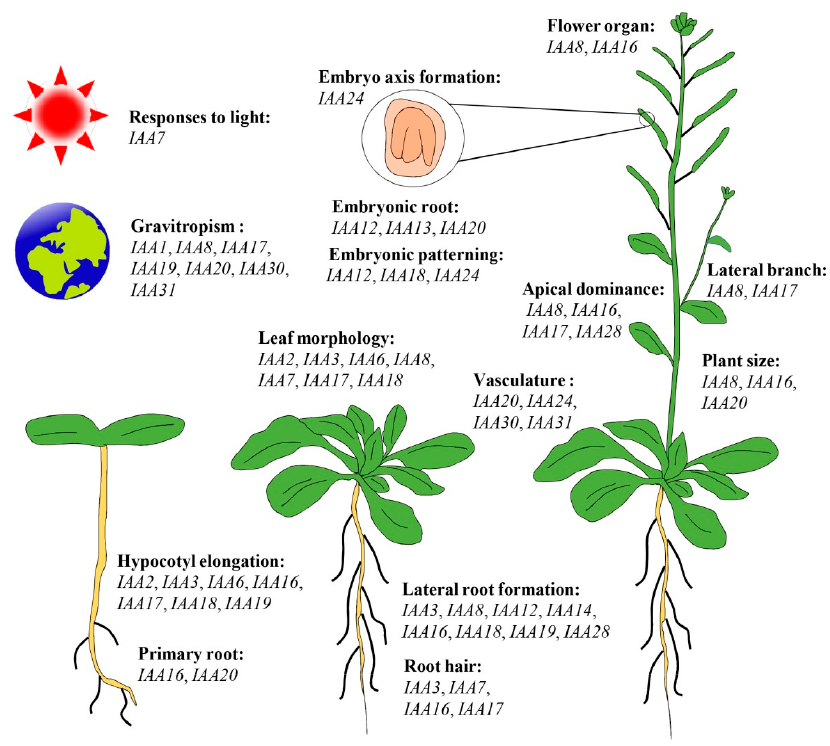
Figure 4. Summary of the functions of Aux/IAA genes in growth and development processes of Arabidopsis thaliana [18,19].